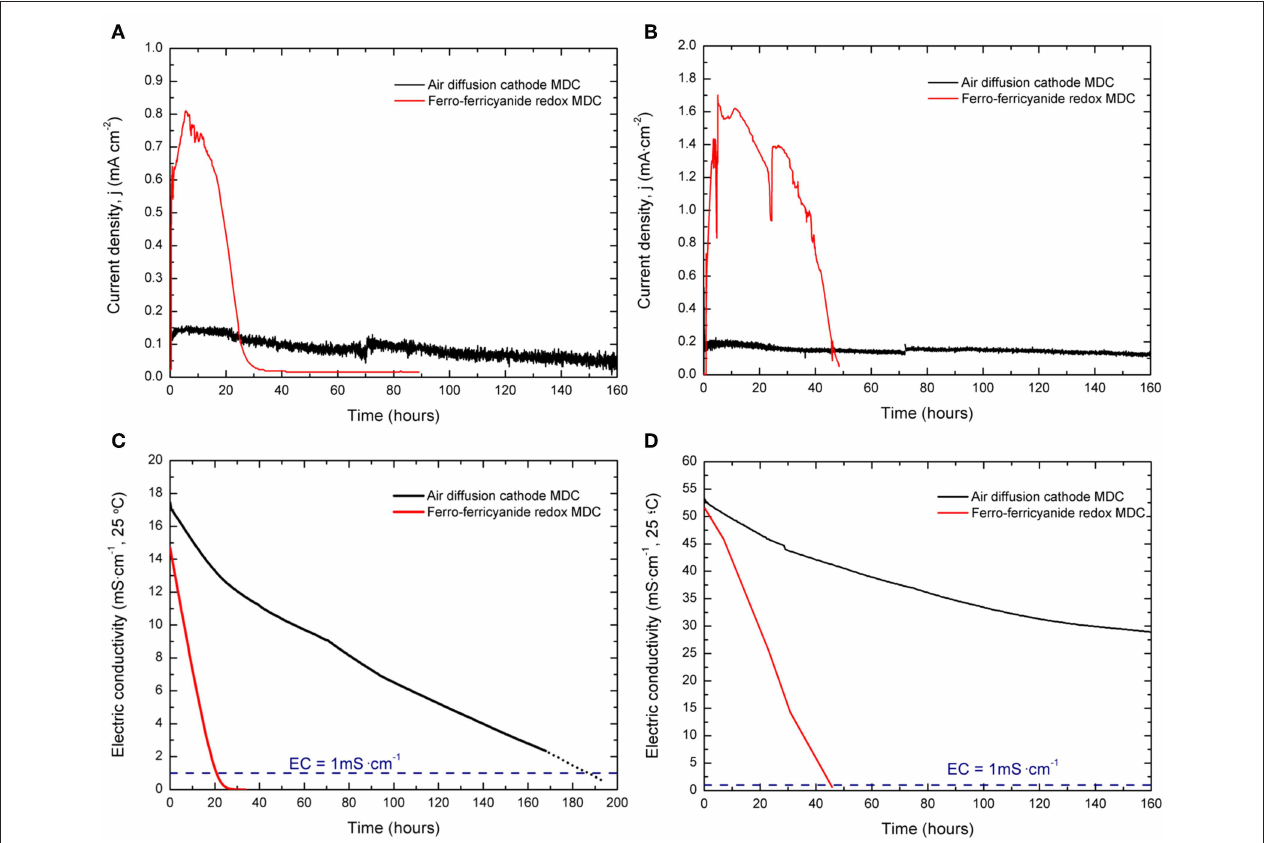
FIGURE 4 | Experimental results for air diffusion cathode MDC (black) and ferro-ferricyanide redox MDC (red). (A,B) Current density vs. time for brackish and sea water desalination. (C,D) Conductivity vs. time for brackish and sea water desalination. Horizontal line shows the threshold for conductivity 1 mS · cm − 1 . The dotted line for the air diffusion cathode MDC results from an interpolation of the electric conductivity below 1 mS · cm − 1 for comparative